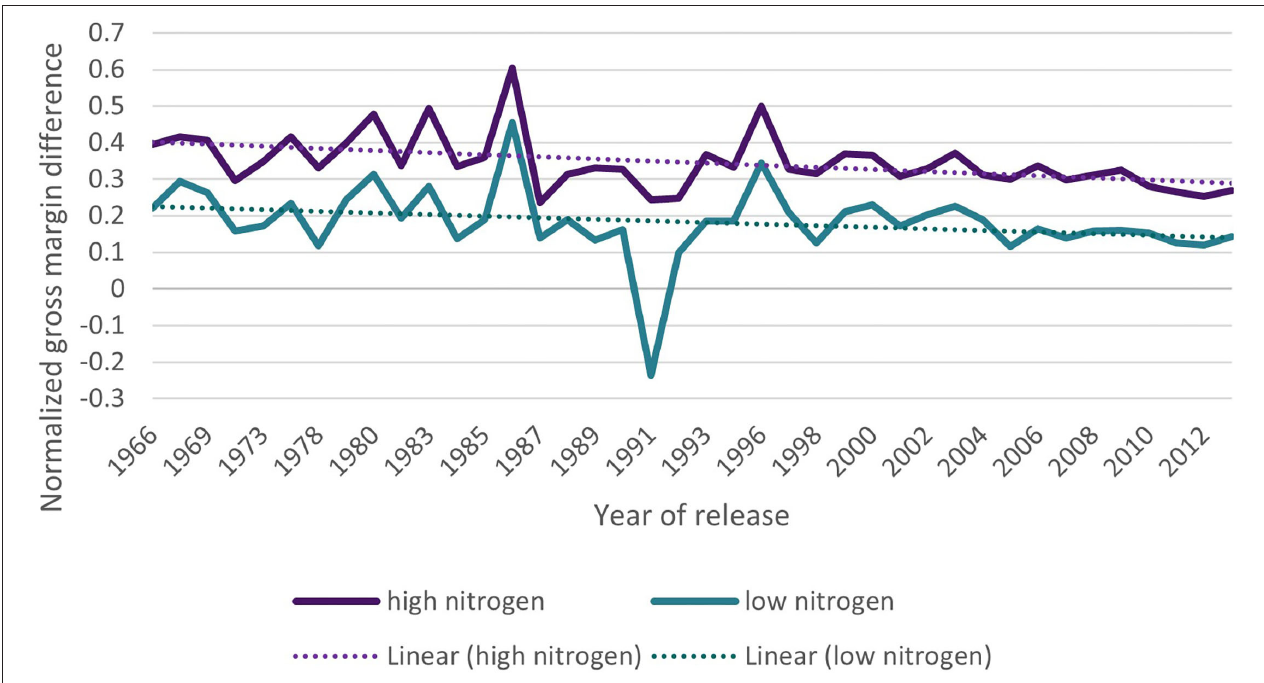
FIGURE 4 | Normalized differences in gross margins (EUR ha-1) between treatments with and without fungicide applications in two trial set-ups with high (purple line) and low (turquoise) nitrogen application; the dotted lines indicate the linear